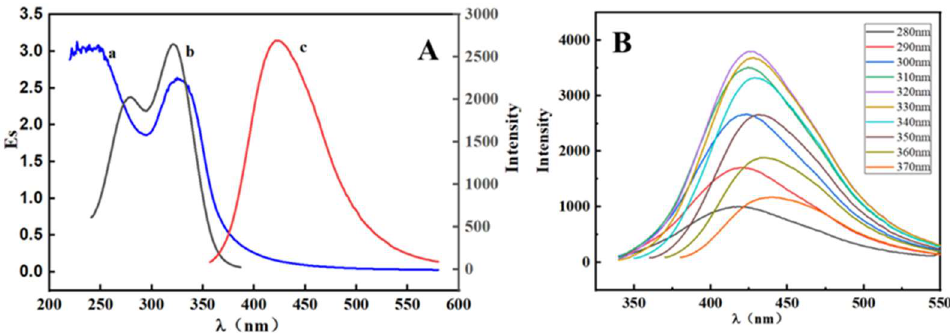
Figure 3. ( A ) UV–Vis absorption (a), excitation (b), and emission (c) of S, N-CQDs; ( B ) Emission spectra at various wavelengths of excitation (280–370 nm).